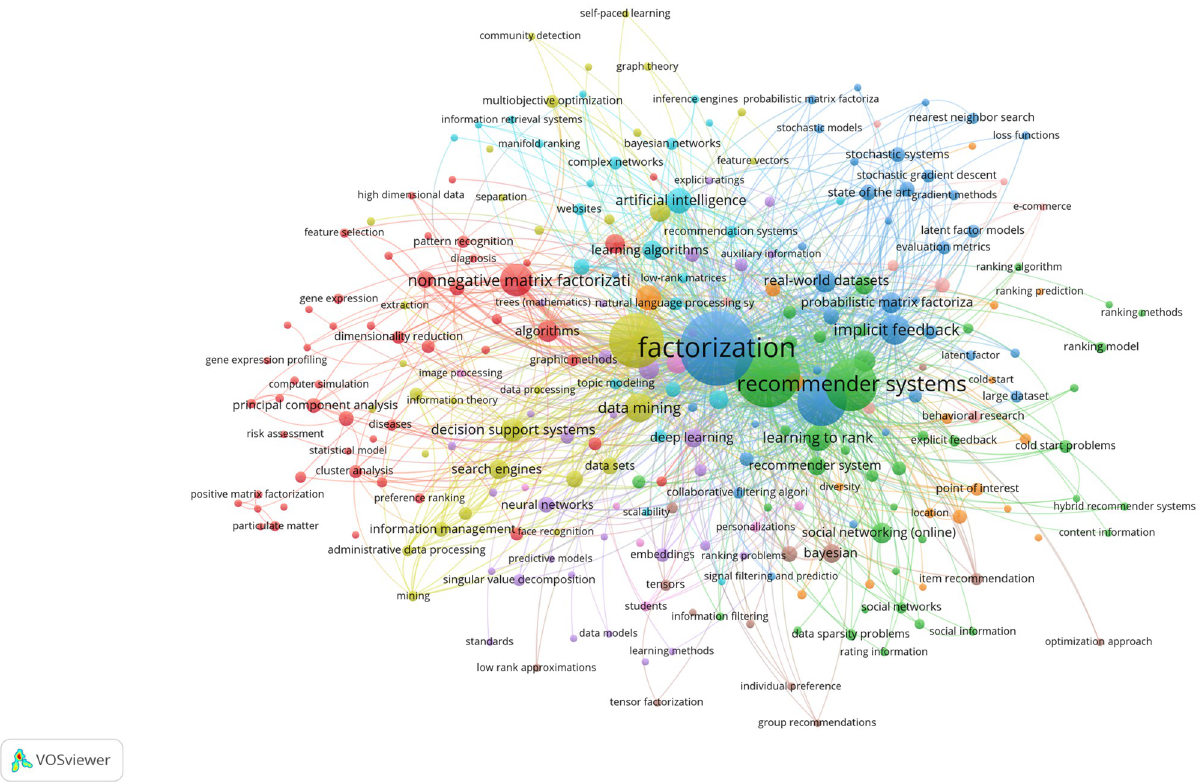
Fig 1. Literature of Matrix factorization and MOO. The figure shows the cooccurrences of keywords in articles from 497 publications queried using Scopus. The search expressions/keywords were matrix factorization and ranking, multi-objective optimization, decision support and multi-objective decision-making. Unique keywords, denoted by the nodes, are connected if they cooccur at least four times. Only publications before the end of December, 2021 are included.